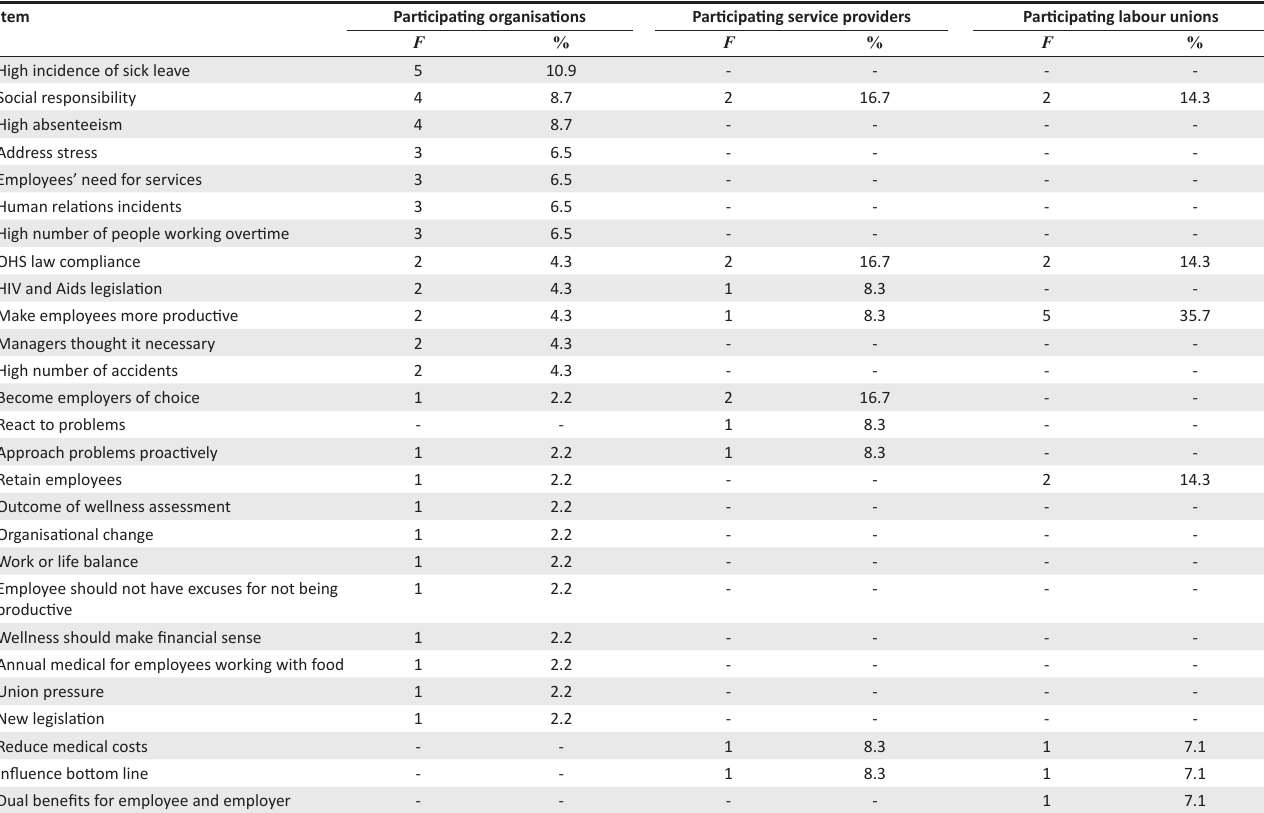
TABLE 4: Reasons for introducing Employee Wellness